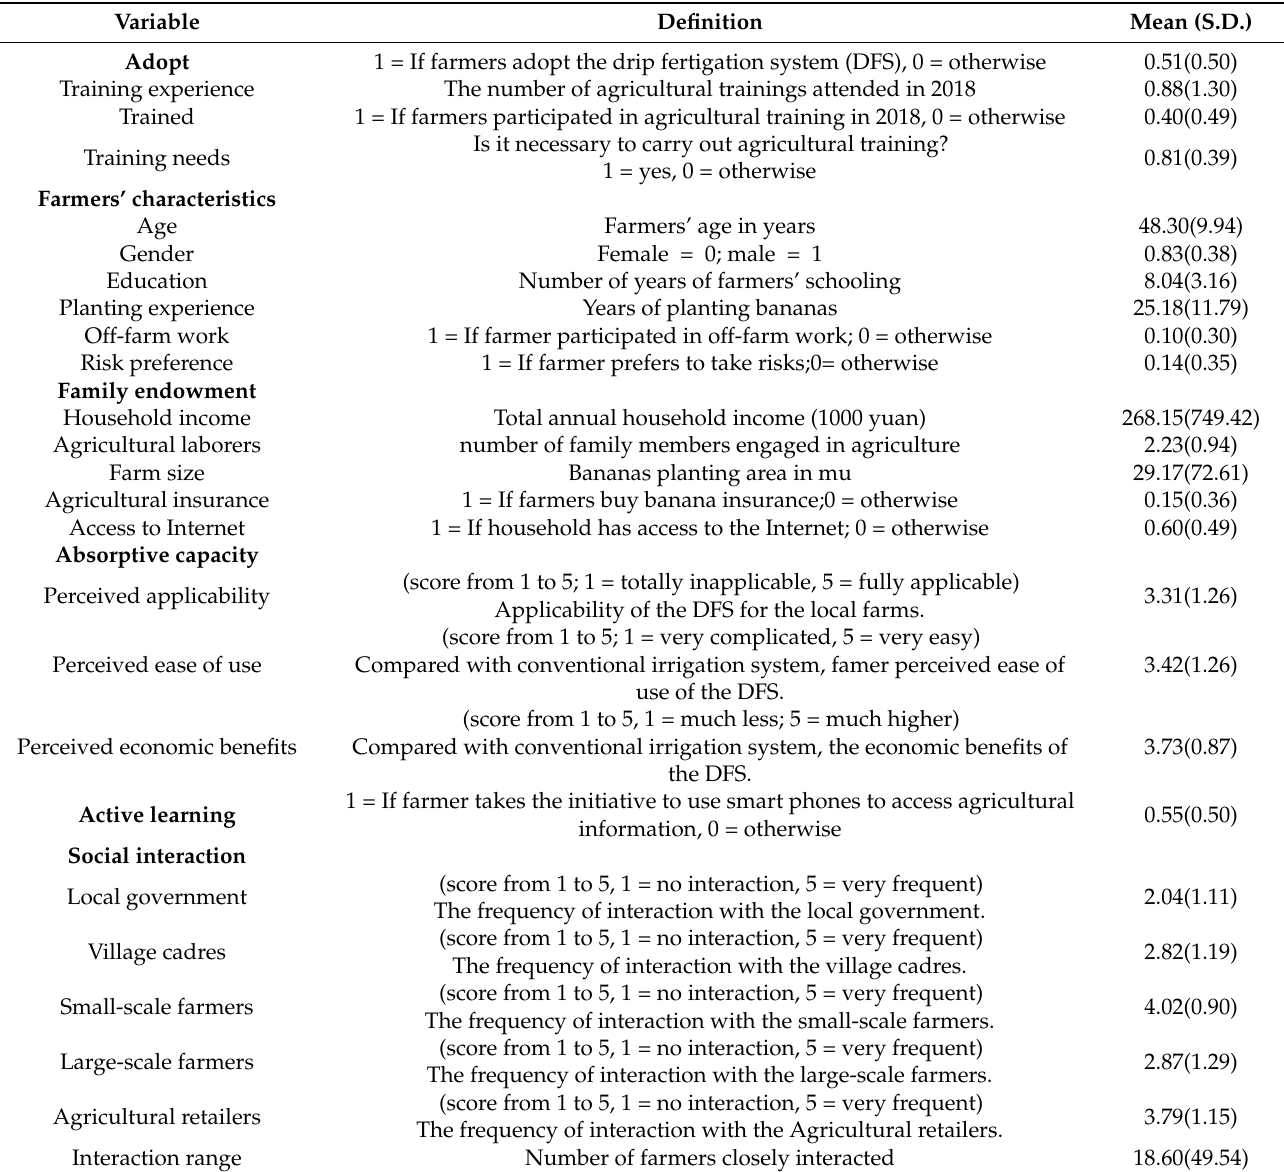
Table 2. The definition and measurement of